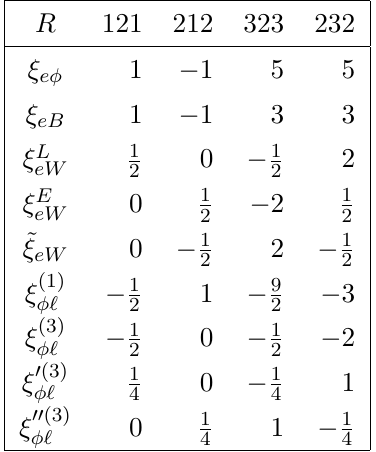
Table 2 . Representation-dependent SU(2) L factors ξ entering the matching